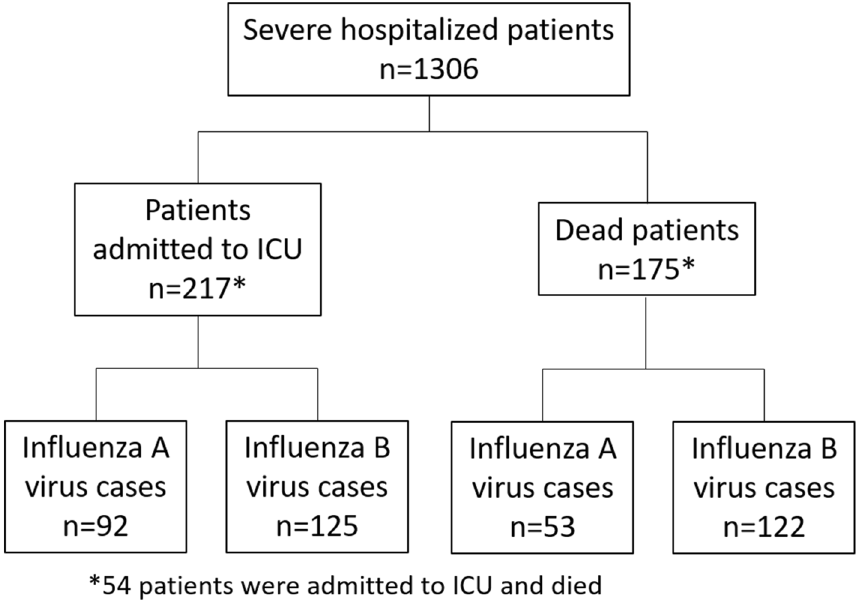
Figure 1. Flow chart of severe hospitalized influenza